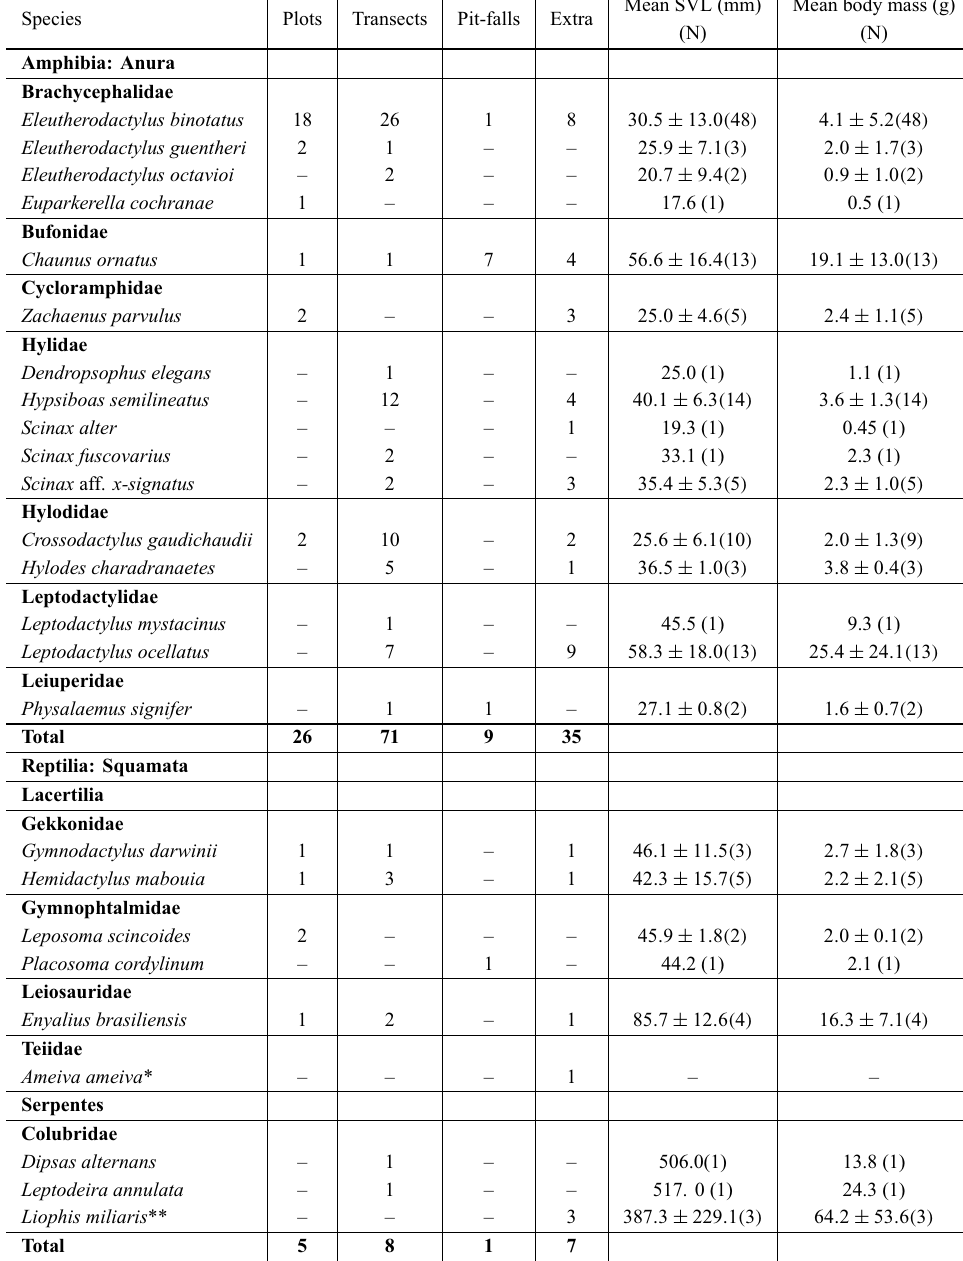
Number of amphibians and reptiles of each species sampled by each sampling method in an Atlantic Rainforest of Morro São João, in southeastern Brazil. Mean values ( ± one standard deviation) of snout- vent length (SVL, in mm) and body mass (in grams), calculated from all animals collected both within and outside (Extra) of the sampling methods, are given for each species (with sample sizes in